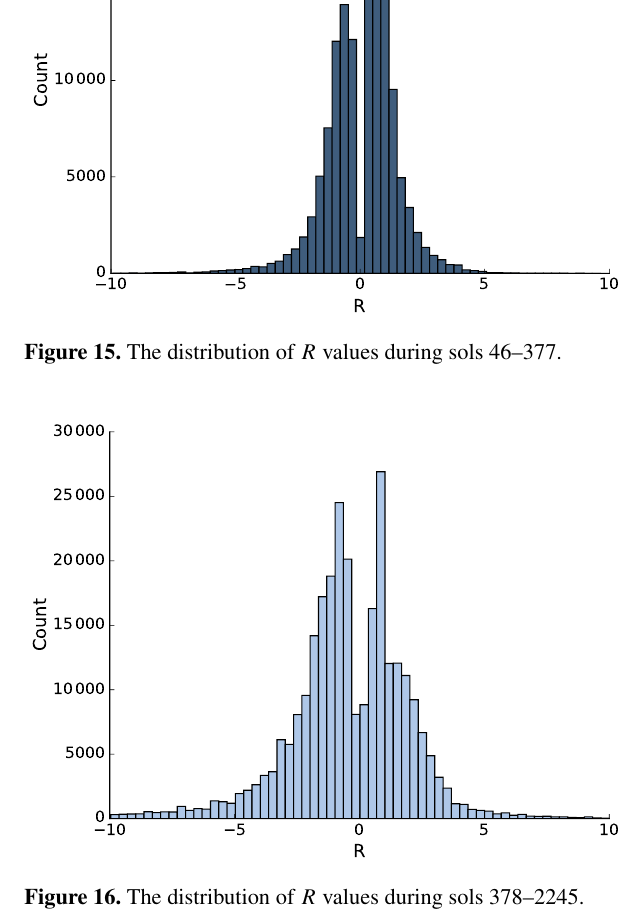
Figure 18. The diurnal standard deviation of the angle